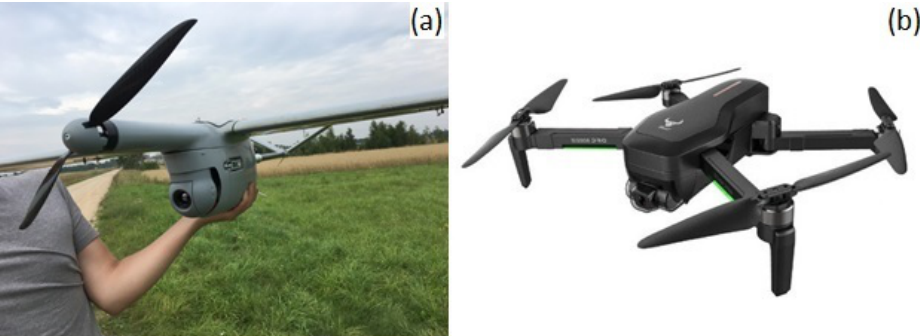
Figure 4. Fixed-wing UAV Buzzard ( a ) and quadcopter SGH906 ( b